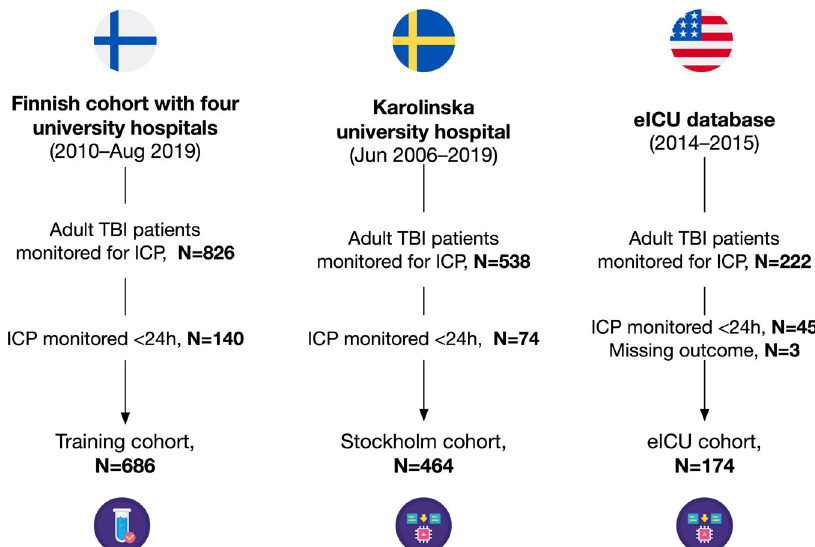
Fig. 2 Study fl ow chart. The training cohort was collected from four university hospitals in Finland and the external validation cohorts were collected from Karolinska University Hospital (Stockholm, Sweden) and the eICU